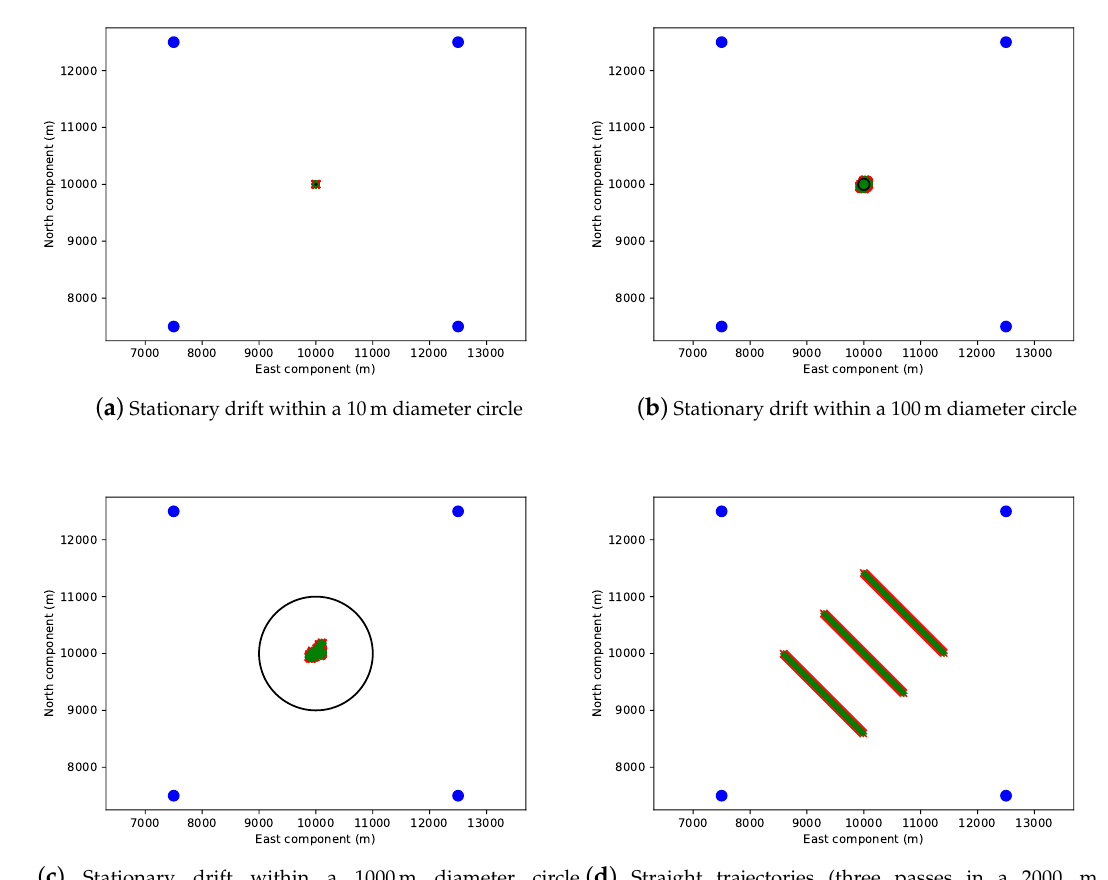
Figure 2. Trajectories of the surface-platform tested in the different inversion schemes. Blue dots represent the position of the seafloor transponders. Green and red points denote the position of the surface platform at ping emission and reception instants, respectively. The three “drifting” trajectories ( a – c ) are implemented by “random walks” inscribed in the black circles. However, for the 1000 m circle ( c ), the random walk never reach the limits of the circle and can be considered as a free trajectory. Subfigure ( d ) shows the straight line